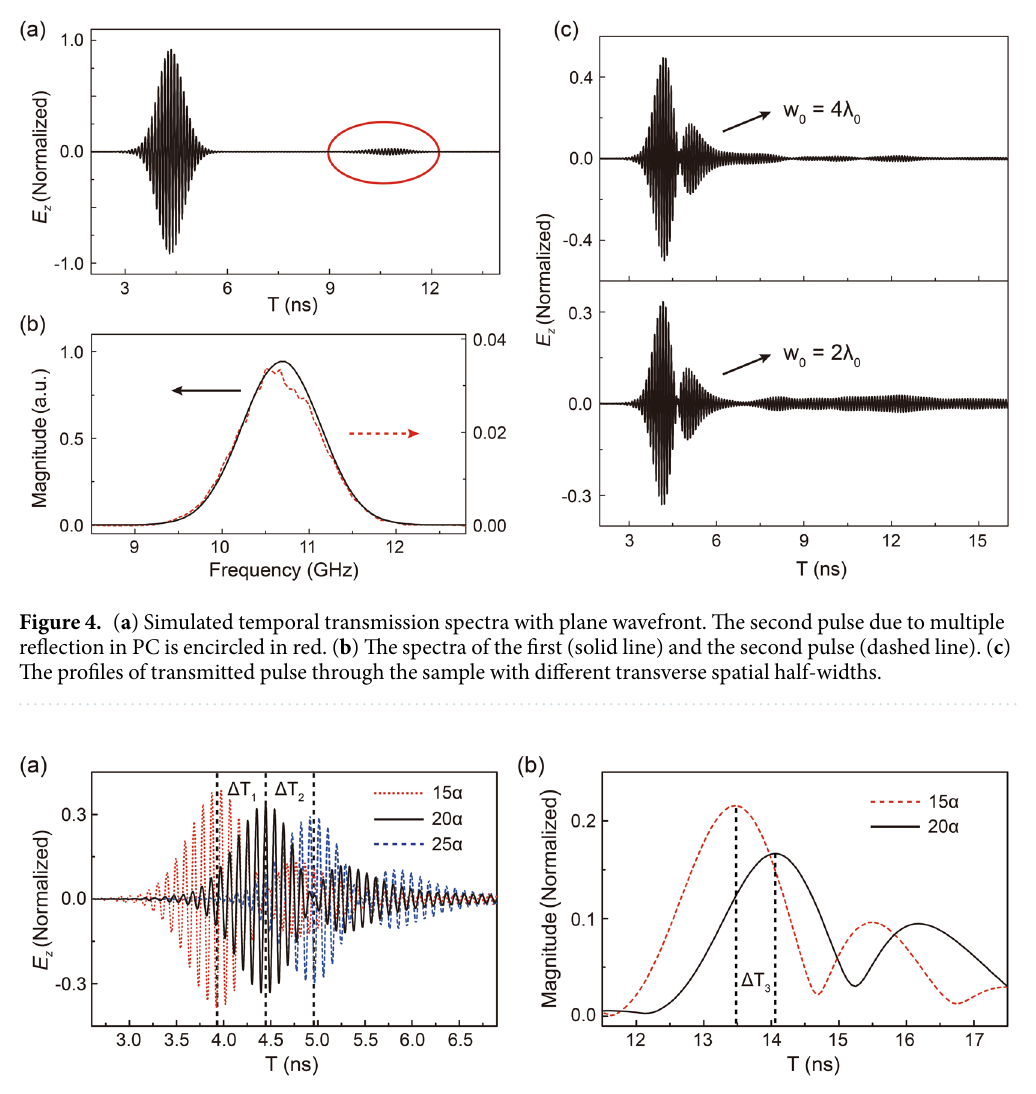
velocities, transmit and are received after propagating through the PC slab. This is also consistent with the fact that the third peak never appears in simulations with effective zero index parameters. Corresponding to the lon-